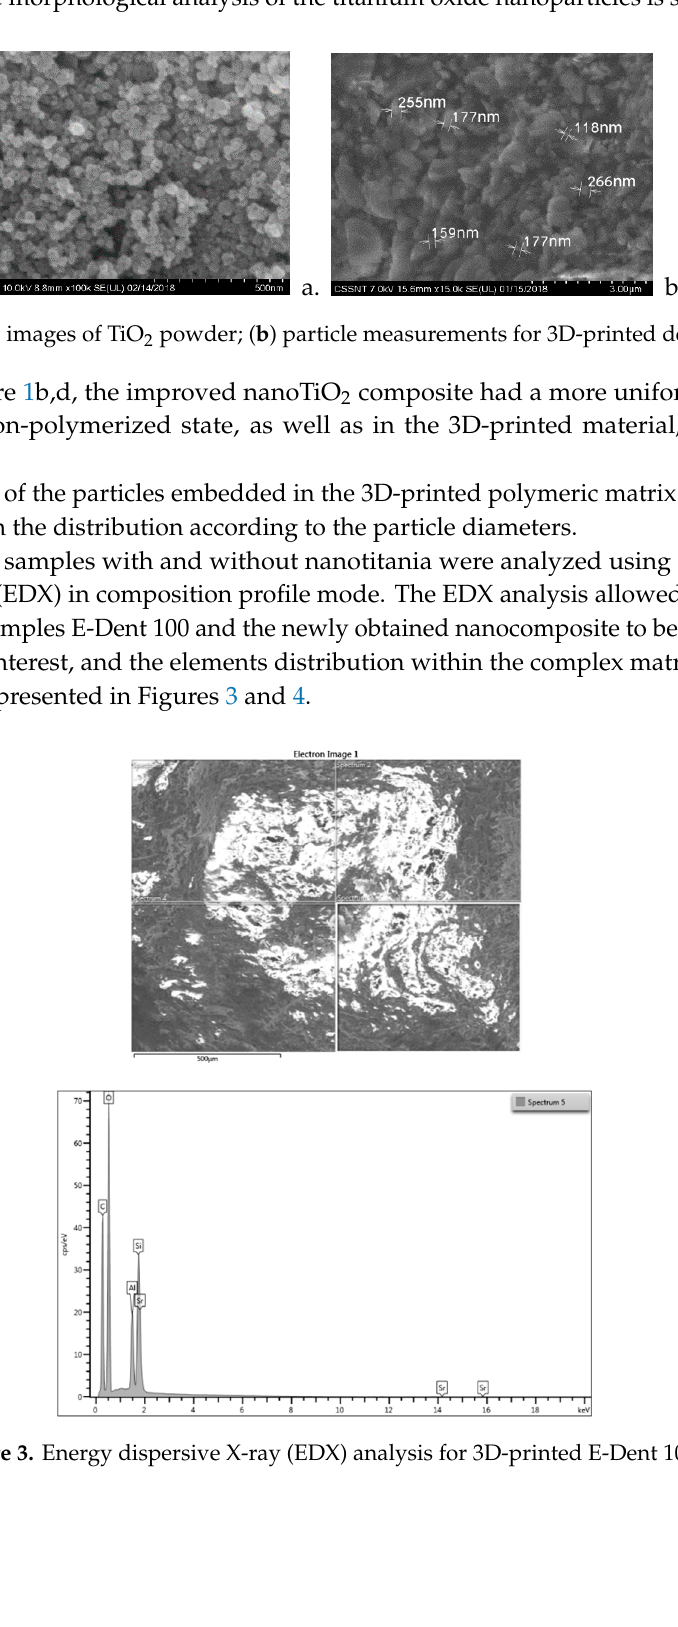
Figure 3. Energy dispersive X-ray (EDX) analysis for 3D-printed E-Dent 100.